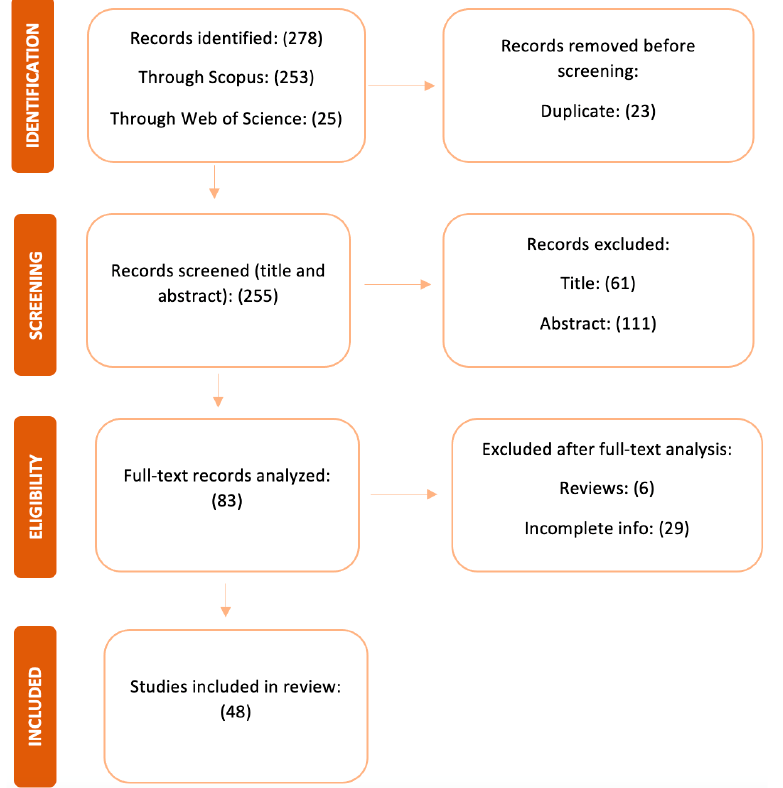
Figure 2. The flowchart of the systematic review process determined the papers selected for the present study (adapted from the PRISMA 2020 flow diagram [28].